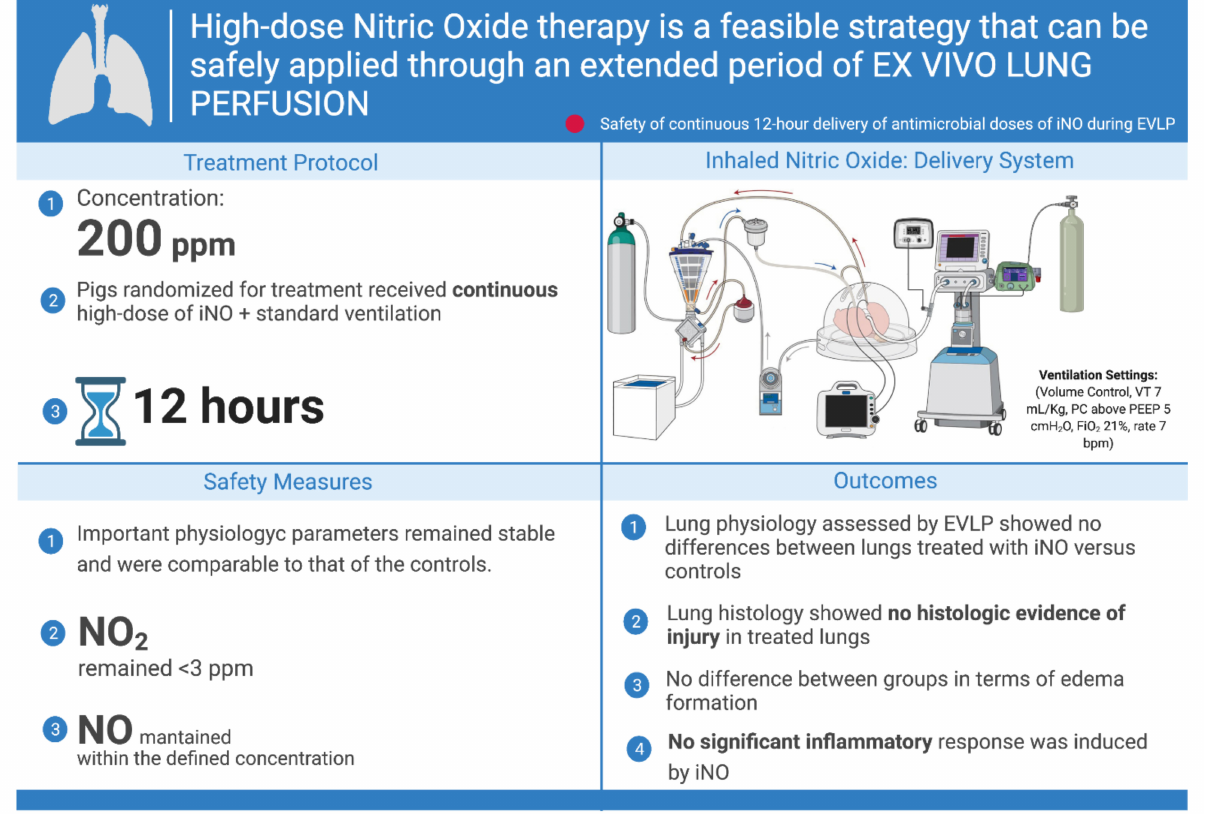
Figure 5. Visual summary of the safety phase study using continuous antimicrobial doses of inhaled nitric oxide during ex vivo lung perfusion. Definition of abbreviations: ppm = parts per million, NO = nitric oxide, iNO = inhaled nitric oxide, NO 2 = nitrogen dioxide, VT = tidal volume, PEEP = positive end-expiratory pressure, bpm = beats per minute, FiO 2 = fraction of inspired oxygen. The figure was created with BioRender.com (accessed on 19 March